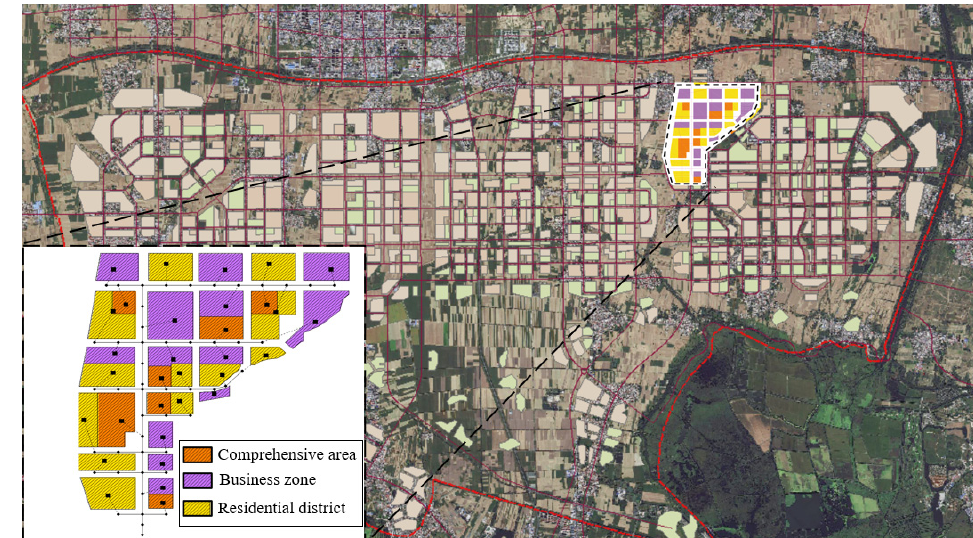
Figure 2. Study area and land use.